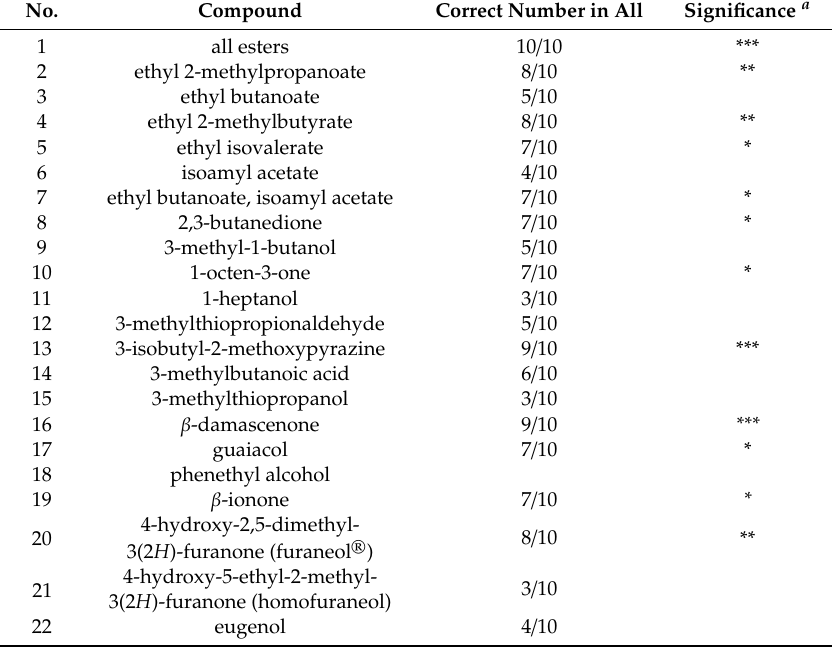
Table 3. Omission tests from complete recombination